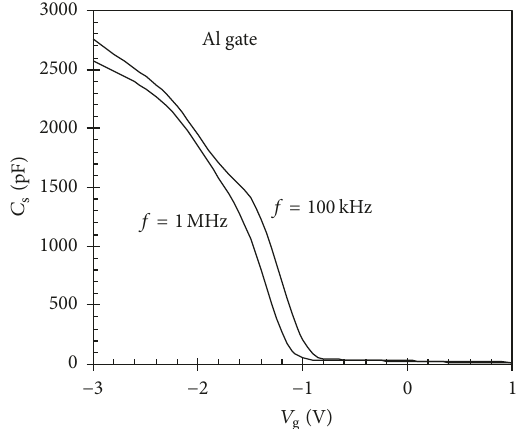
Figure 7: C-V characteristics at 100 kHz and 1MHz, obtained in serial measurement mode for an Al gate.